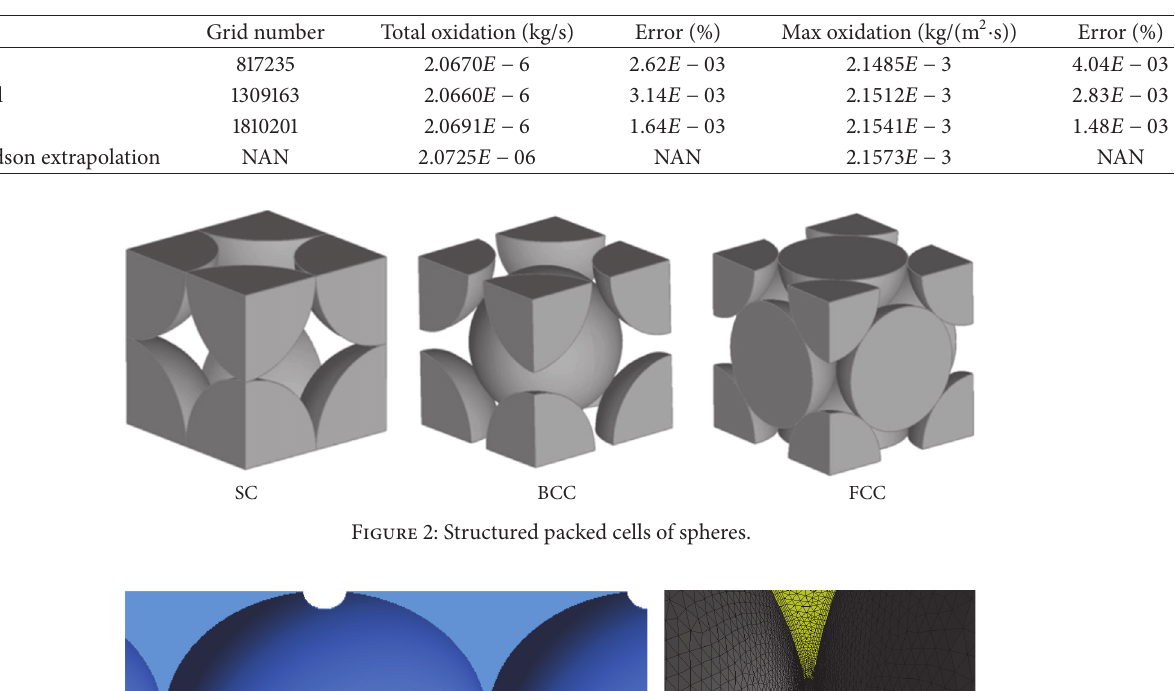
Table 1: Results of grid independence test.